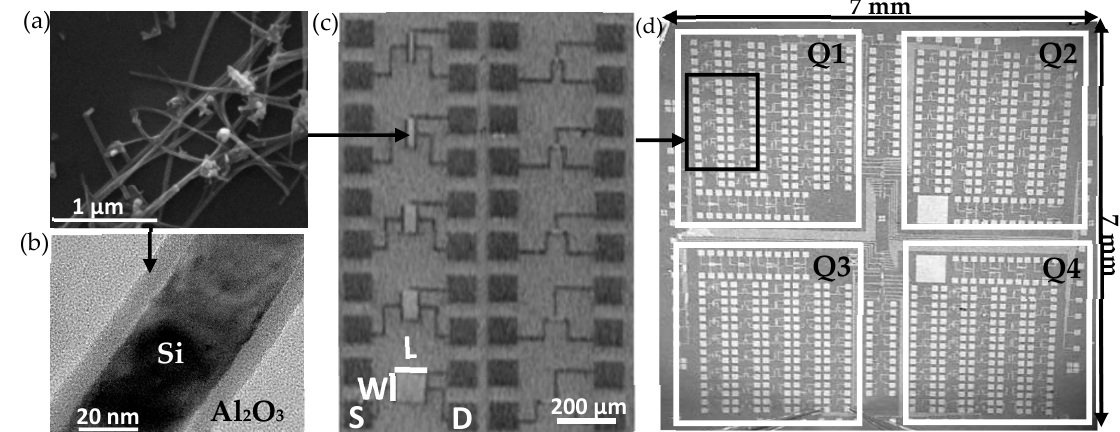
Figure 1. ( a ) SEM image of the Si nanonet (NN) after transfer on heavily doped Si substrate covered with a 200 nm thick Si 3 N 4 . ( b ) High-resolution TEM (HRTEM) image displaying an Al 2 O 3 passivated Si nanowire. ( c ) Optical image of Al 2 O 3 passivated Si NN field effect transistors (FETs) presenting different channel geometries. On the image, W, L, S and D refer to channel width, channel length, source and drain, respectively. ( d ) Optical image of the resulting chip. Q1, Q2, Q3 and Q4 denote the di ff erent quarters of the